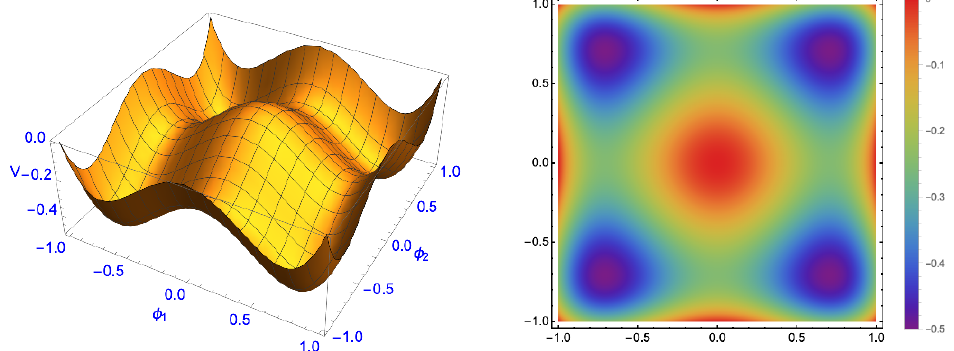
Figure 3 . Left Panel: the representation of the potential configuration for λ 12 = 0 . Right panel: the corresponding heat map for such configuration.